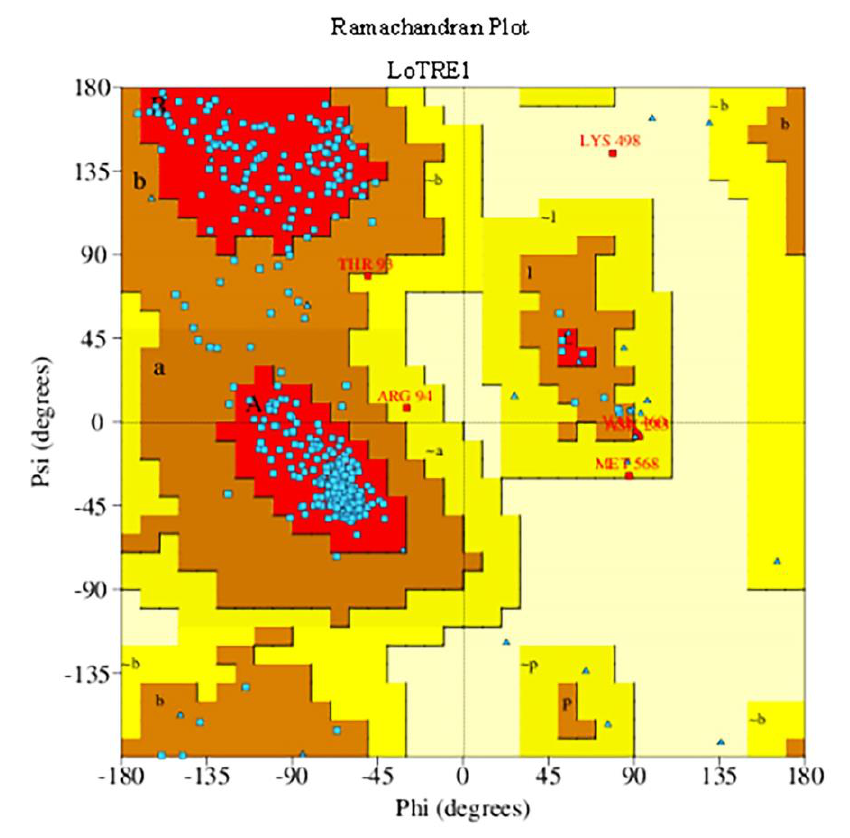
Figure 6. Ramachandran plot of LoTRE1 .